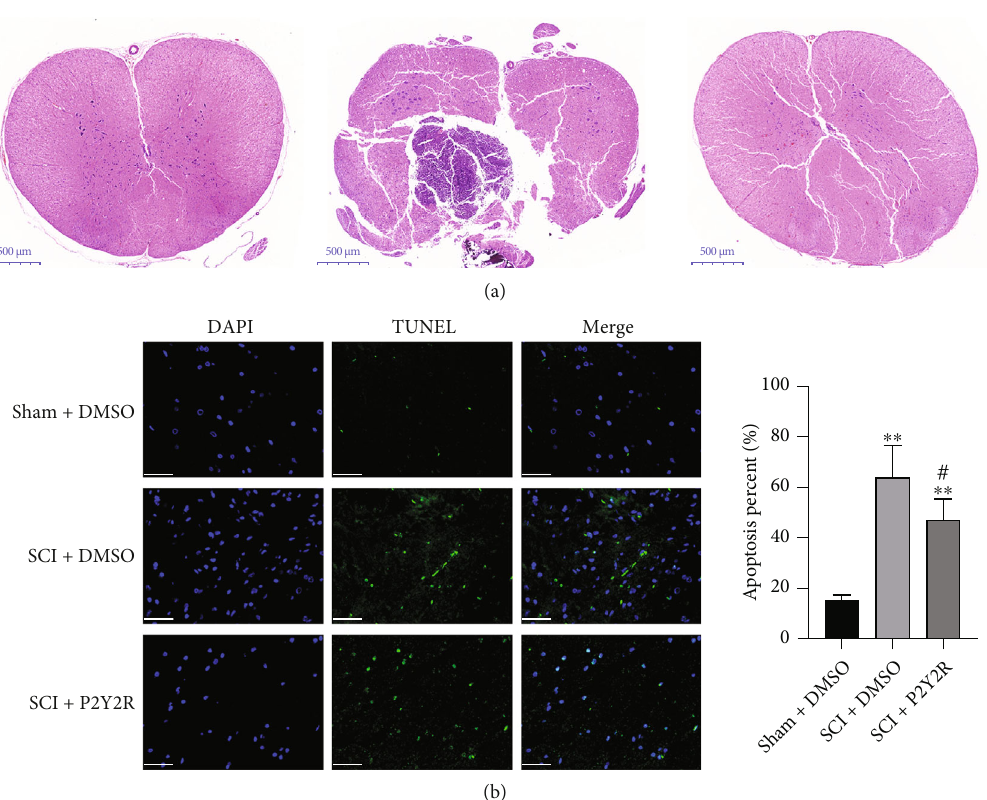
Figure 3: (a) The results of HE staining. (b) The apoptosis of spinal cord tissue detected by TUNEL assay. Scale bar = 50 μ m. ∗∗ p < 0 : 01 compared with the sham+DMSO group; # p < 0 : 05 compared with the SCI+DMSO group.